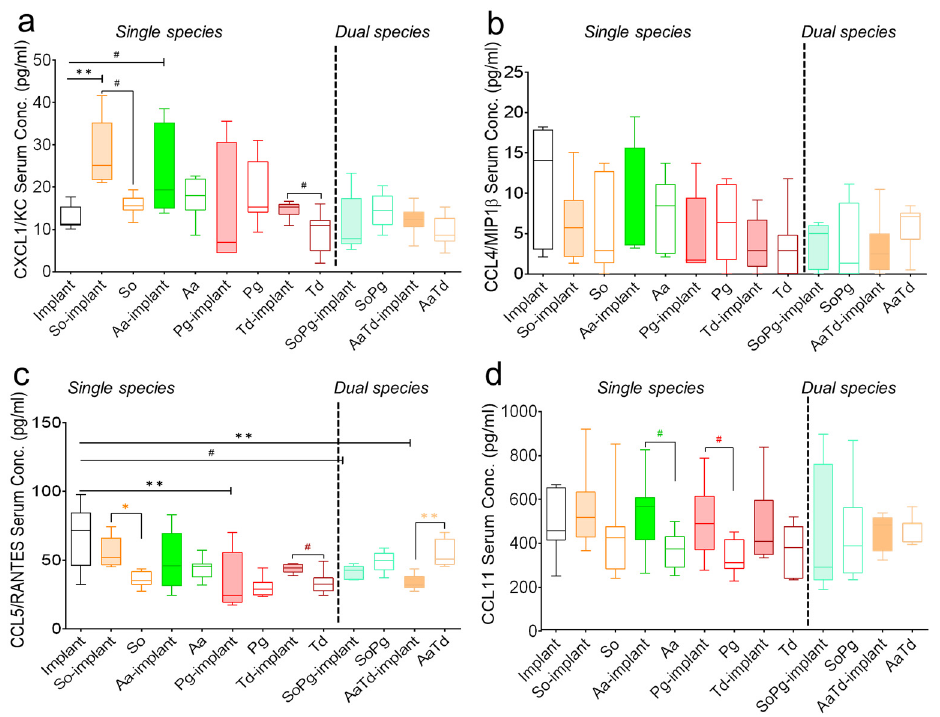
Figure 4. Systemic expression of chemokines in mice. Black bars represent sterile implants, filled bars indicate infected implants, and empty colored bars indicate infected tissues for CXCL1/KC ( a ), CCL4/MIP1 β ( b ), CCL5/RANTES ( c ), and CCL11 ( d ). Data were analyzed animal-wise (biological replicates ( n = 3), technical replicates (3 each)). Significant values were adjusted by the Bonferroni correction for multiple tests. Symbols **, *, and # indicate p < 0.01, p < 0.05, and significant p -value prior to Bonferroni correction, respectively. Black symbols represent significant differences between sterile and infected implants. Significant differences between infected implants and infected sham-operated tissues are indicated by colored symbols. Abbreviations: So ( S. oralis ), Aa ( A. actinomycetemcomitans ), Pg ( P. gingivalis ), Td ( T. denticola ).